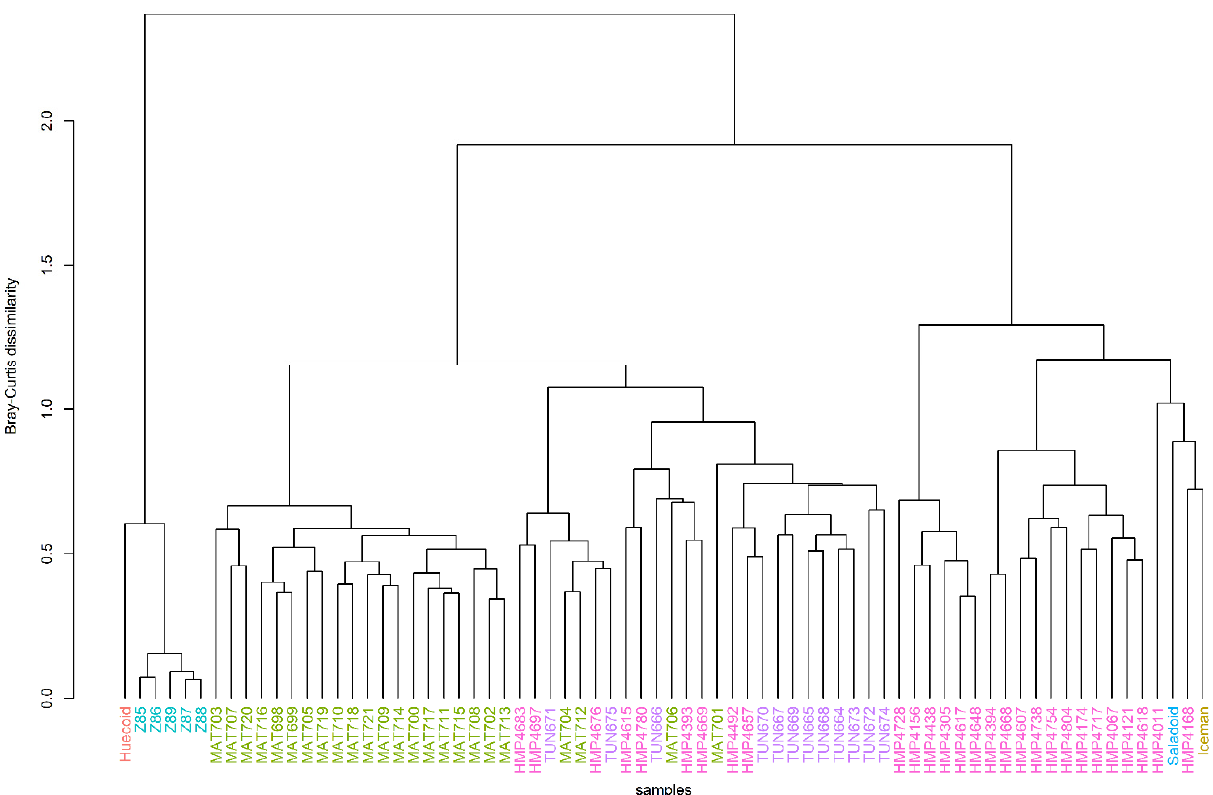
Figure 3. Hierarchical clustering. Hierarchical clustering of the Huecoid (coral/red), Saladoid (blue) and Mexican (tur- quoise) coprolites, and the Iceman gut sample (golden) as well as the Matses (green), Tunapuco (purple), and US (pink) extant stools using the Bray–Curtis dissimilarity